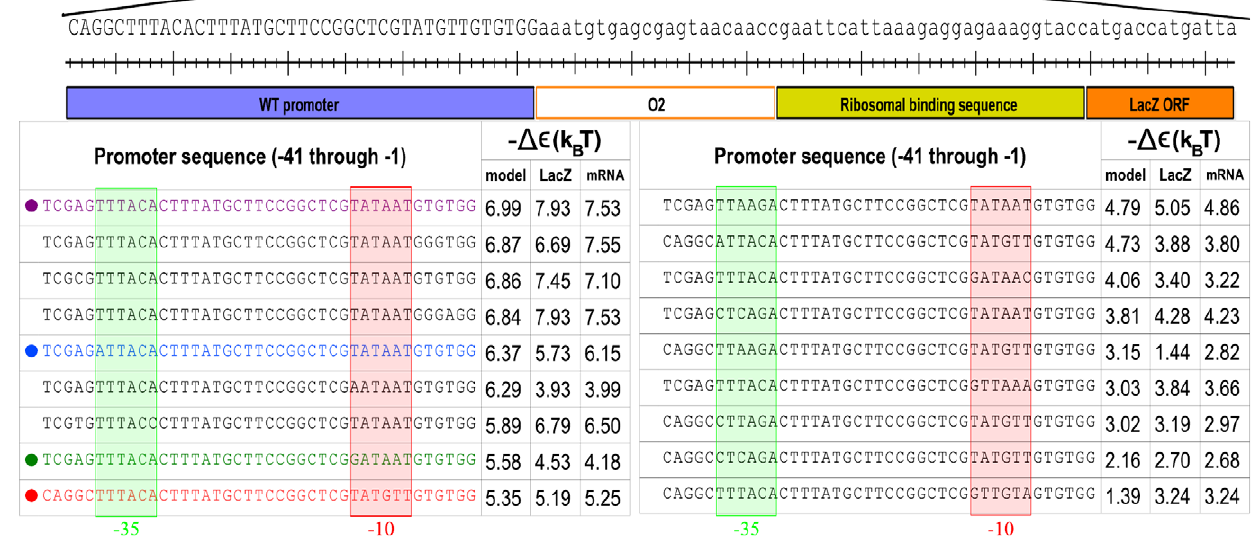
Figure 3. Schematic of DNA construct inserted in the galK region. The area between the promoter and the LacZ start codon is shown in more detail below along with a table displaying the specific RNAP binding sites (promoters) listed in order of descending binding affinity. The wild-type binding sequence is shown in red text, the lac UV5 sequence is shown in magenta text, and two additional promoters are marked by blue text and green text. The data points involving these four promoters will maintain this color coding throughout every figure. The { 35 and { 10 RNAP recognition sequences are highlighted in a green box and a red box, respectively. The bases in these regions carry the most weight in the energy matrix. Sequences are available in text format in SI Text S4.